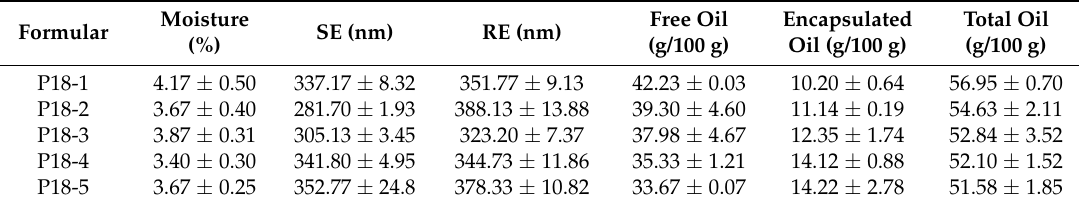
Table 4. The effect of various spray drying condition on moisture amount, particle size and oil amount (free oil, encapsulated oil and total oil) of spray-dried olive oil powder using γ -CD and hydrogenated lecithin (n =